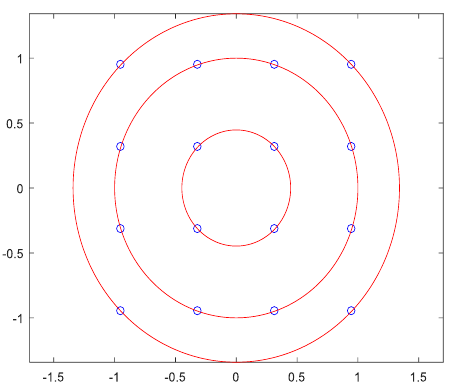
Figure 6. Two input forms of hash encryption. Blue circles represent the user symbols as the input of hash (each points represents four user bits), and red circles represent the modulus of user symbols as the input of hash encryption.